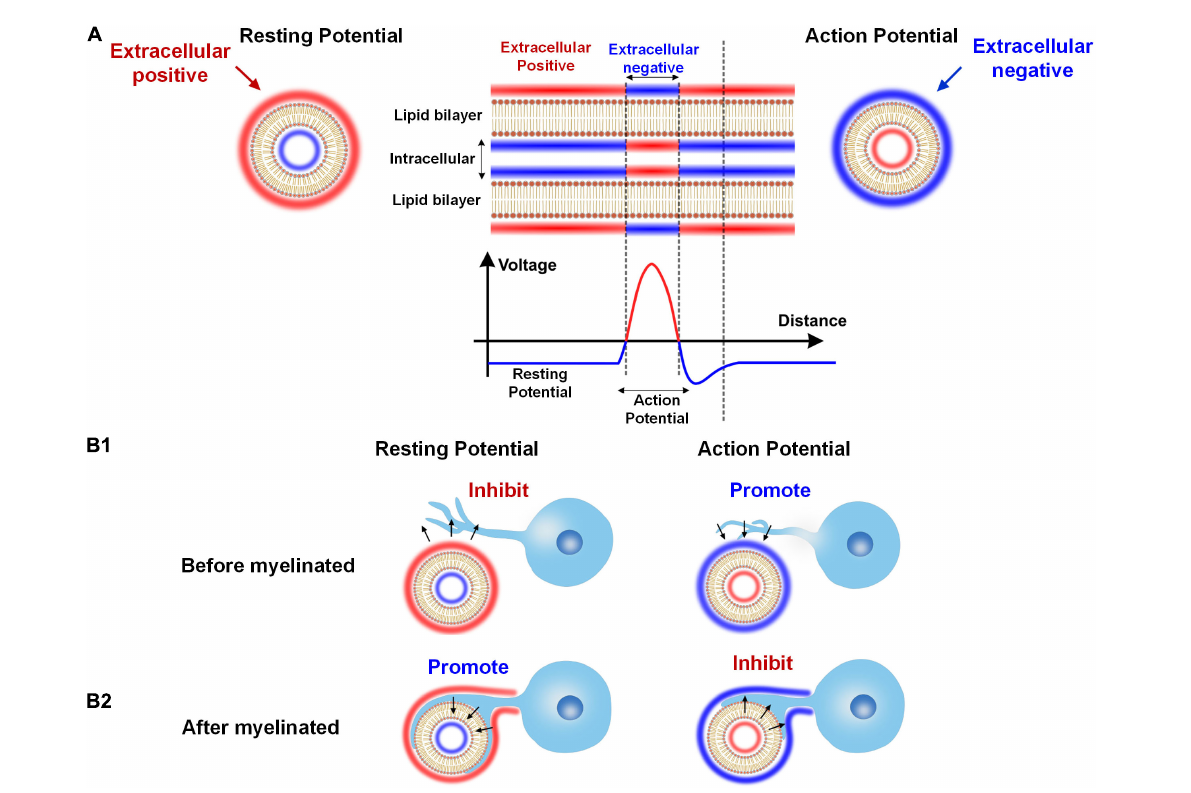
FIGURE11 The dual effect of neural activity on myelination. (A) The extracellular E-field of neural activity on an axon: The resting potential induces a positive extracellular E-field, while the action potential induces a negative extracellular E-field. (B1) When the myelin cell has not attached to the axon, the positive extracellular E-field by the resting potential inhibits myelin growth, and the negative extracellular E-field by the action potential promotes myelin growth. (B2) When the myelin cell is attached to the axon, the resting and action potential effect will